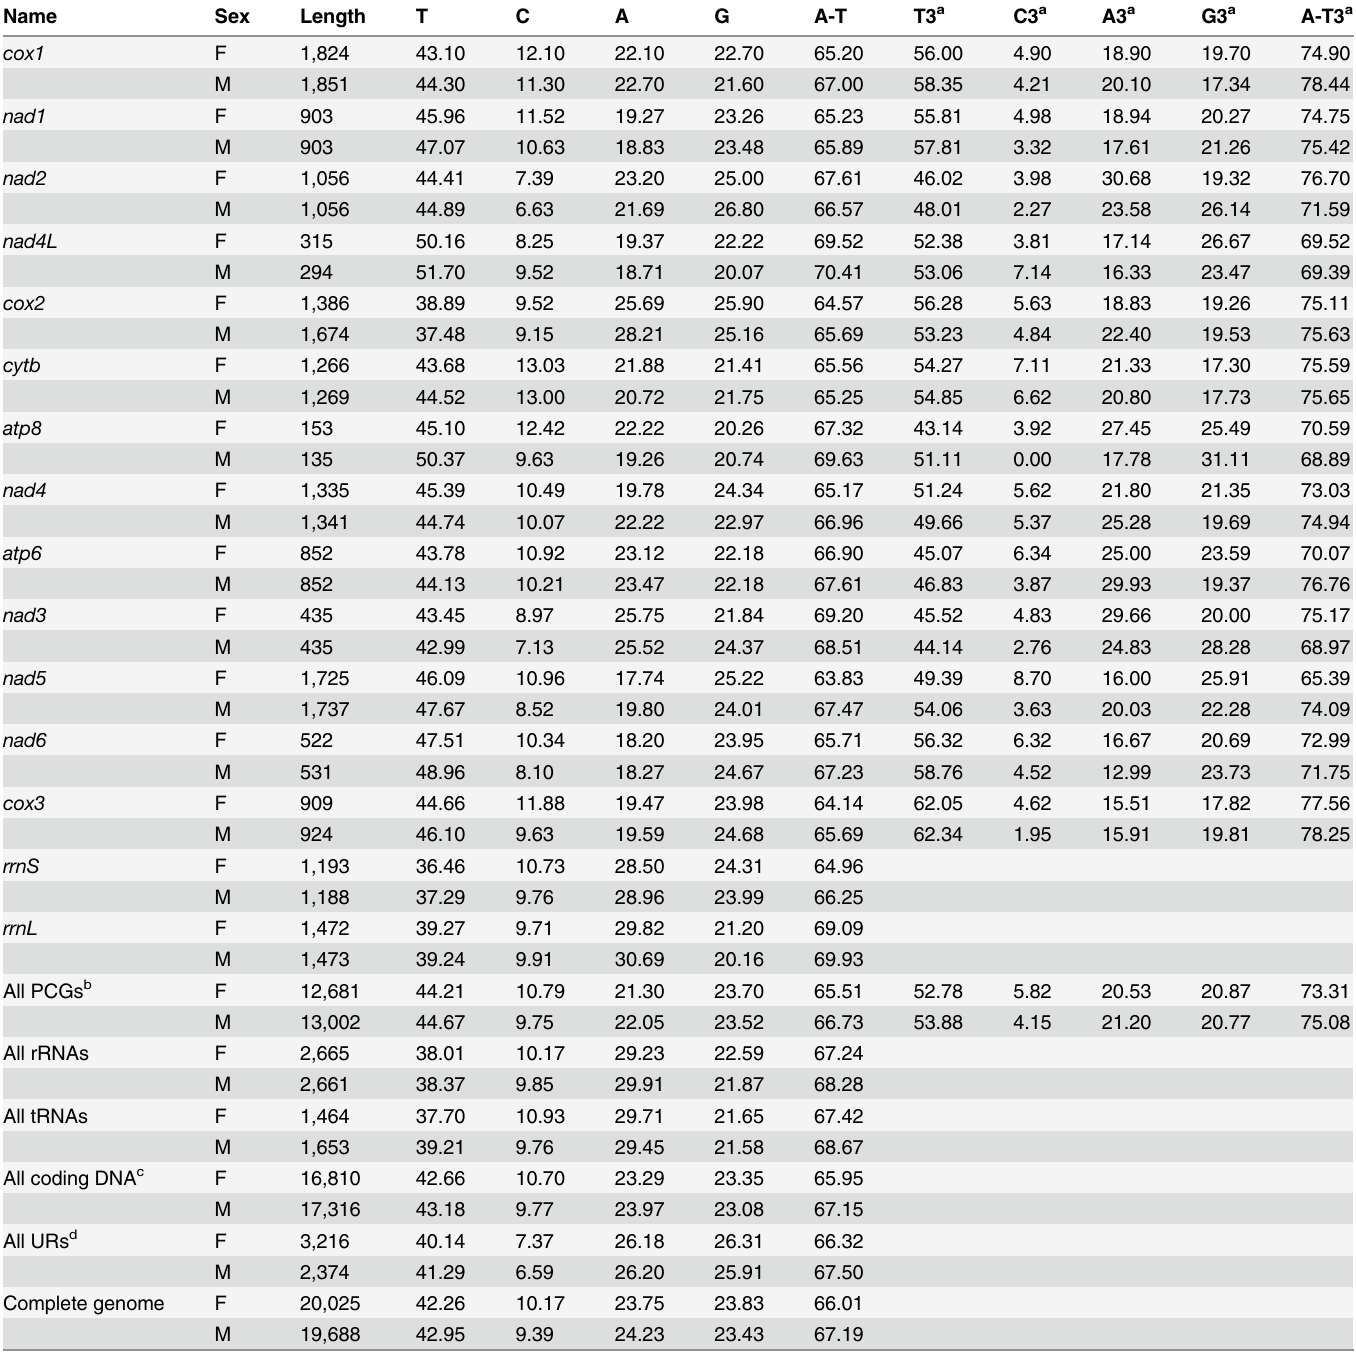
Table 2. Nucleotide composition (%) of Meretrix lamarckii F and M genomes.